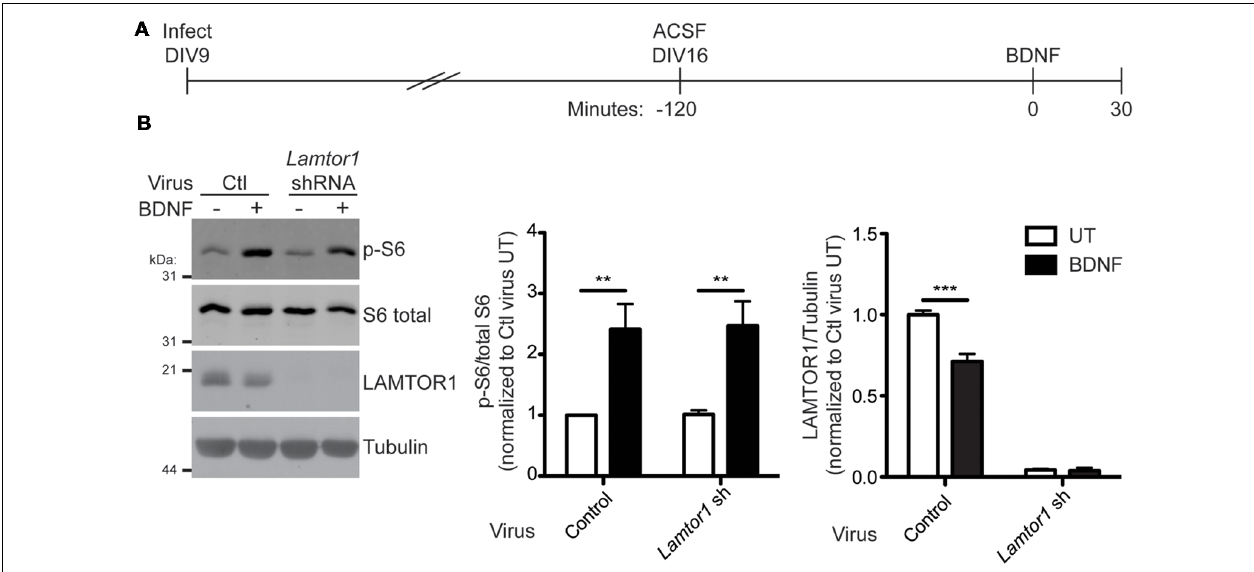
FIGURE 8 | LAMTOR1 is not required for BDNF activation of mTORC1 in hippocampal neurons. (A) Scheme of the viral infection and BDNF stimulation paradigm. Hippocampal neurons were infected with control (Ctl) or Lamtor1 shRNA lentivirus at 9 days in vitro (DIV). On DIV16, cells were placed in ACSF for 2 h before stimulation with 100 ng/ml BDNF for 30 min. (B) Lysates from samples treated as in A were blotted to detect p-S6 (top), S6 total (second from top), LAMTOR1 (second from bottom), and tubulin (bottom) levels. Quantifications of pS6 relative to total S6 [two-way ANOVA: BDNF treatment p = 0.0002 ( F ( 1 ) = 24.07), virus p = 0.91 ( F ( 1 ) = 0.013), interaction p = 0.94 ( F ( 1 ) = 0.0052); N = 5; Bonferroni post hoc test ∗∗ p < 0.01) and of LAMTOR1 relative to tubulin [two-way ANOVA: BDNF treatment p = 0.0009 ( F ( 1 ) = 26.60), virus p < 0.0001 ( F ( 1 ) = 822.6), interaction p = 0.001 ( F ( 1 ) = 25.04); N = 3; Bonferroni post hoc test ∗∗∗ p < 0.001] are shown to the right of the Western blot images and are normalized to the control untreated (UT)